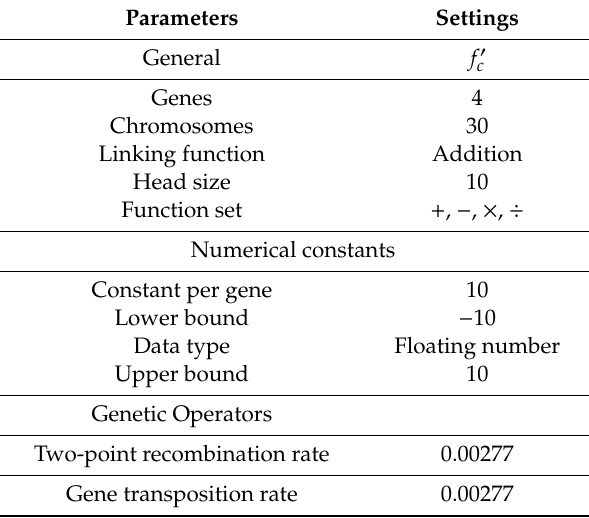
Table 6. Input parameters assigned in the gene expression programming (GEP)